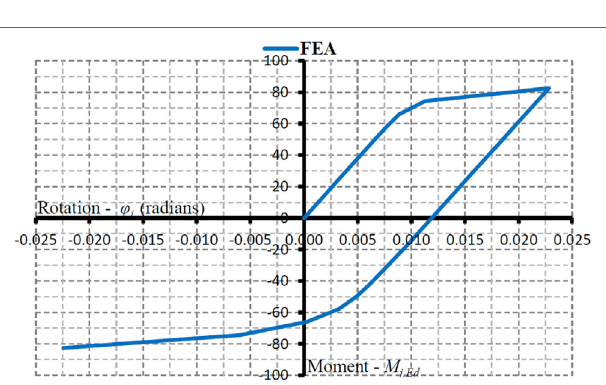
Figure 14 | Moment–rotation for reduced beam section in this FEA study.